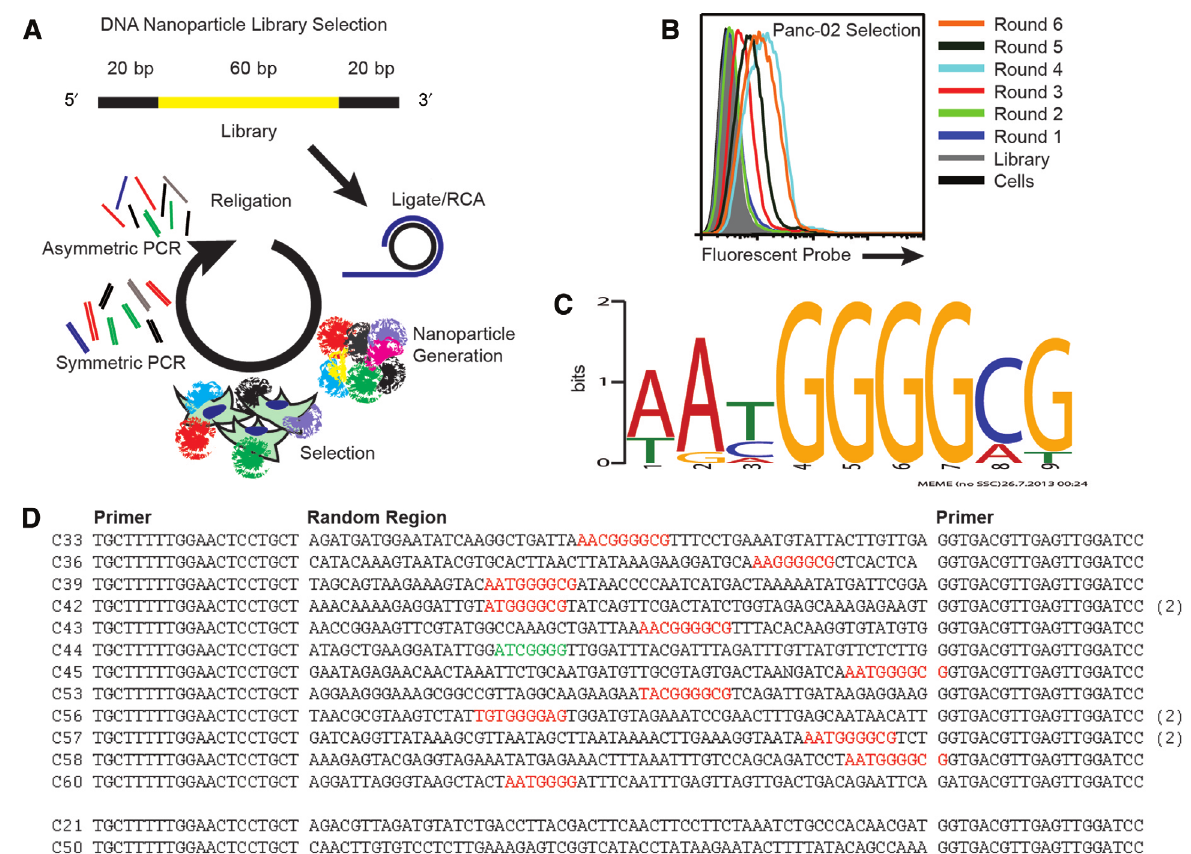
Figure 1 Panc-02 selection. (A) Schematic of DeNAno selection procedure. (B) Panc-02 cell staining of six rounds of selection and library. (C) Sequence motif present in 11/14 clones. (D) Alignment of Panc-02-selected DeNAno clones. Seventeen clones were sequenced, with 14 unique sequences obtained (C42, C56, and C57 sequences were each present